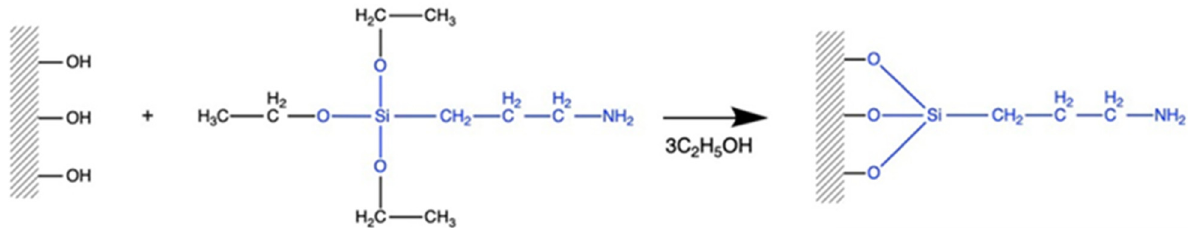
Scheme 1. The functionalization of zeolite surface with